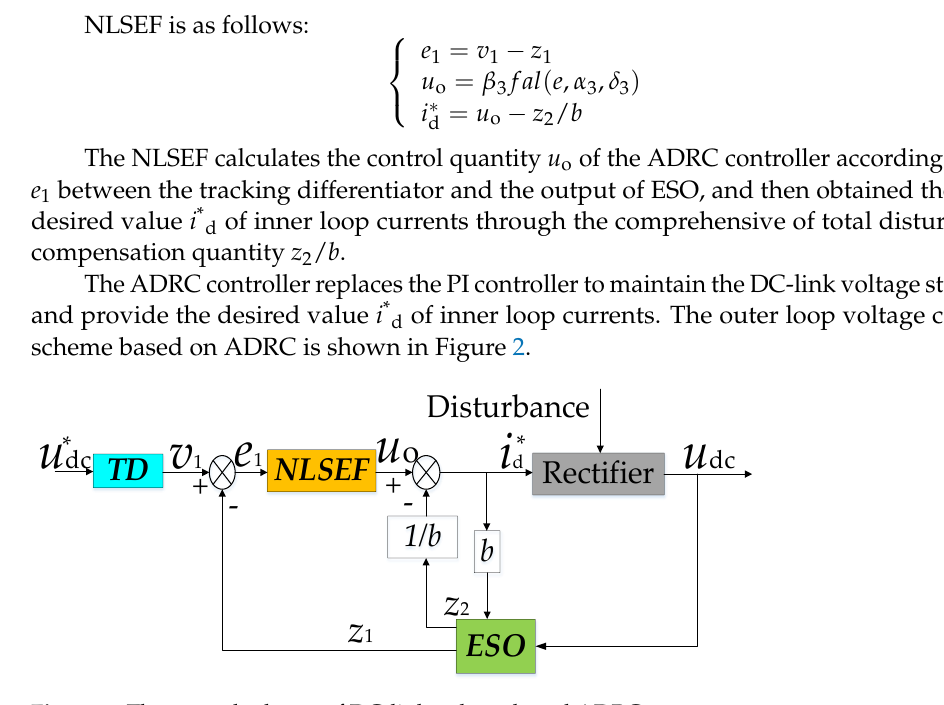
Figure 2. The control scheme of DC-link voltage based ADRC.